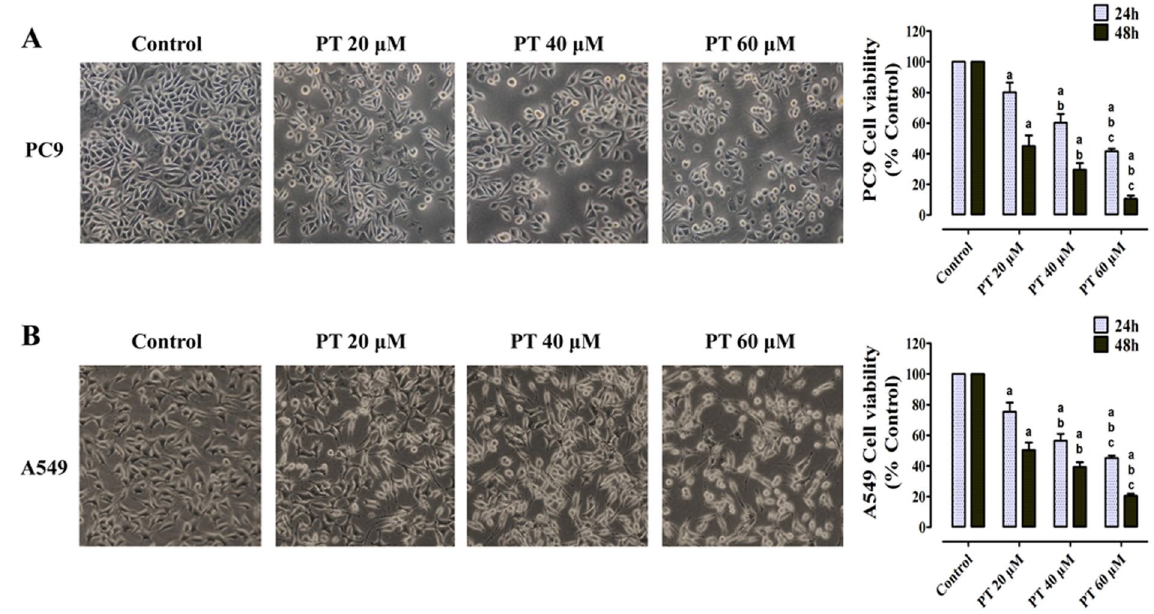
Figure 1. Effect of PT treatment on the viability and morphology of PC9 and A549 cells. Both cell lines were treated with increasing concentrations of PT (20, 40, and 60 μ M) and assessed at time points of 24 and 48 h. The cell viability was analyzed by CCK-8 and expressed as OD values (% Control). The morphology of both cells were observed under an inverted phase-contrast microscope after the cells were treated for 24 h, and images were obtained. Significant cell shrinkage and a decreased cellular attachment rate were observed in the PT treatment groups with a dose dependent manner. All of the results were expressed as the mean ± SD; n = 6. a P < 0.05 vs . the control group, b P < 0.05 vs . the 20 μ M PT-treated group, c P < 0.05 vs . the 40 μ M PT-treated